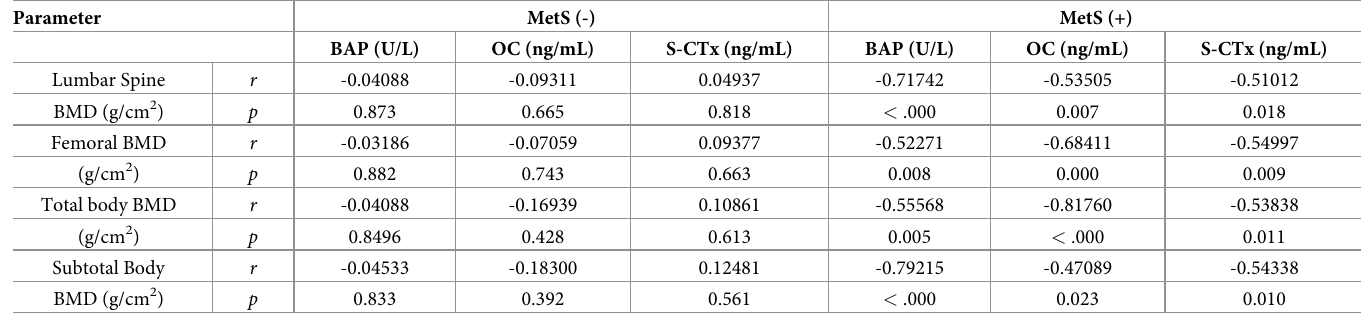
Table 3. Pearson’s correlation between bone biomarkers and bone mineral density measured at four sites in female adolescents with and without metabolic syndrome.